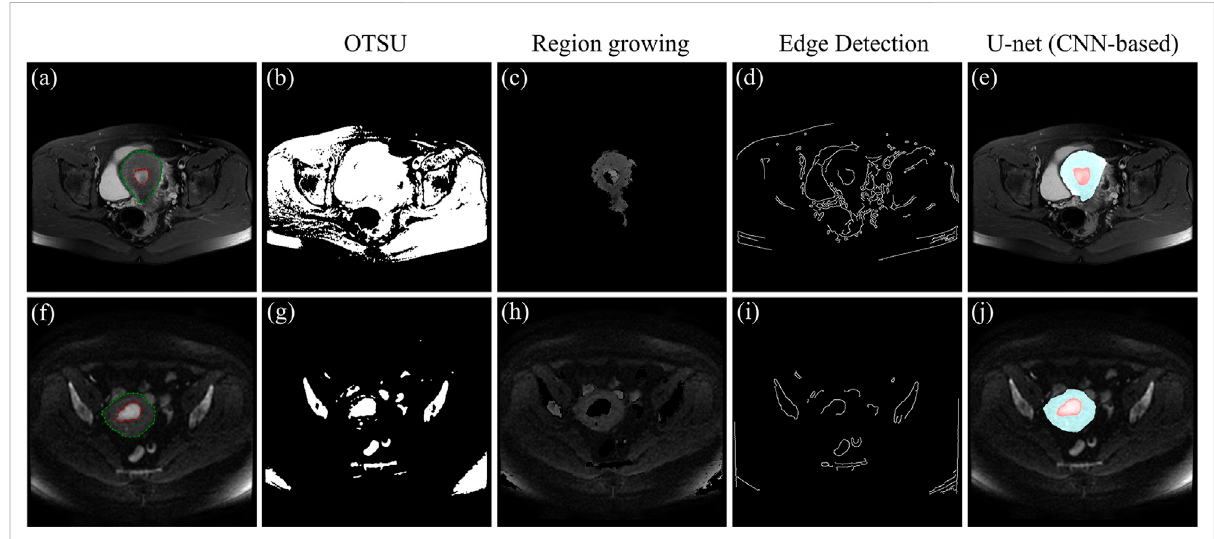
FIGURE 7 (A) and (F) MRI images of the test set, where the red outline is the ground-truth of the tumor and the green outline is the ground-truth of the uterus. (B) and (G) Segmentation results of the OTSU algorithm. (C) and (H) Segmentation results of the region growth algorithm. (D) and (I) Segmentation results based on edge detection. (E) and (J) Segmentation results of the U-net, where the blue area is the uterus region and the red area is the tumor